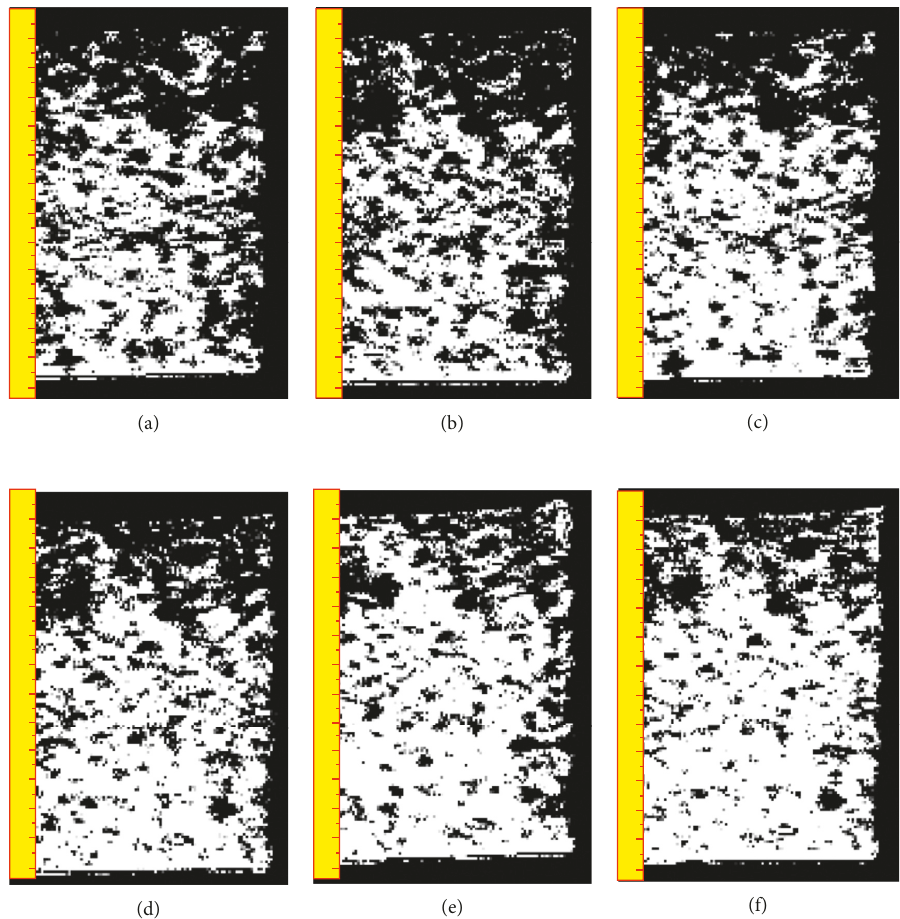
Figure 11: Phase of pure water leaching. (a) 1 h, (b) 2 h, (c) 3h, (d) 4h, (e) 5h, and (f)